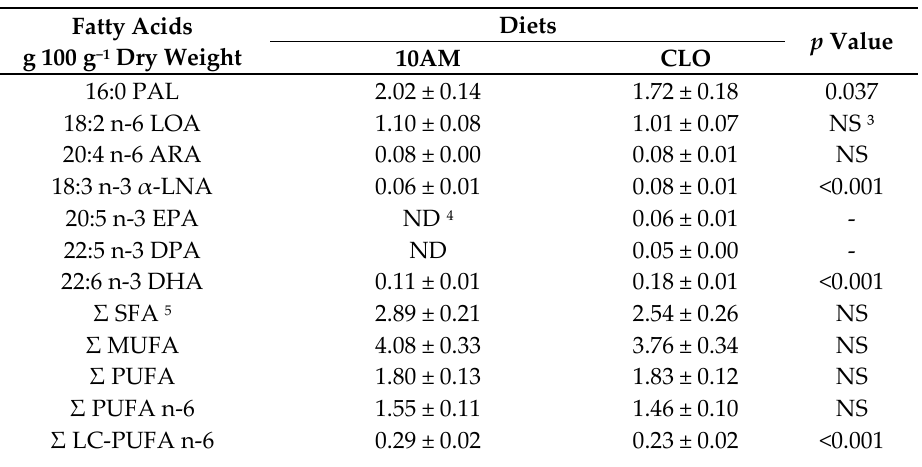
Table 3. Whole body fatty acid composition of Nile tilapia juveniles fed two sources